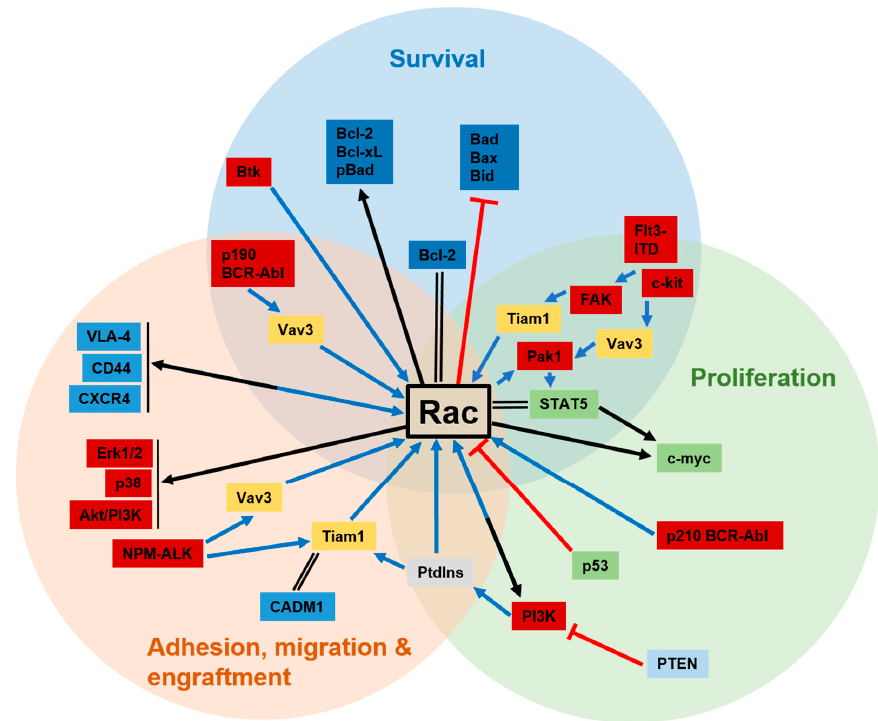
Figure 1. Schematic illustration of Rac signaling pathways contributing to adhesion, migration and engraftment, survival, and proliferation of hematological tumor cells. Depicted are upstream and downstream molecules and interaction partners of Rac GTPases that have been found in the different types of leukemia and lymphoma. Rac activating pathways are represented by blue arrows, direct or indirect activation downstream of Rac are represented by black arrows, direct interactions are marked by double black lines, and blocking processes are indicated by red bar-headed